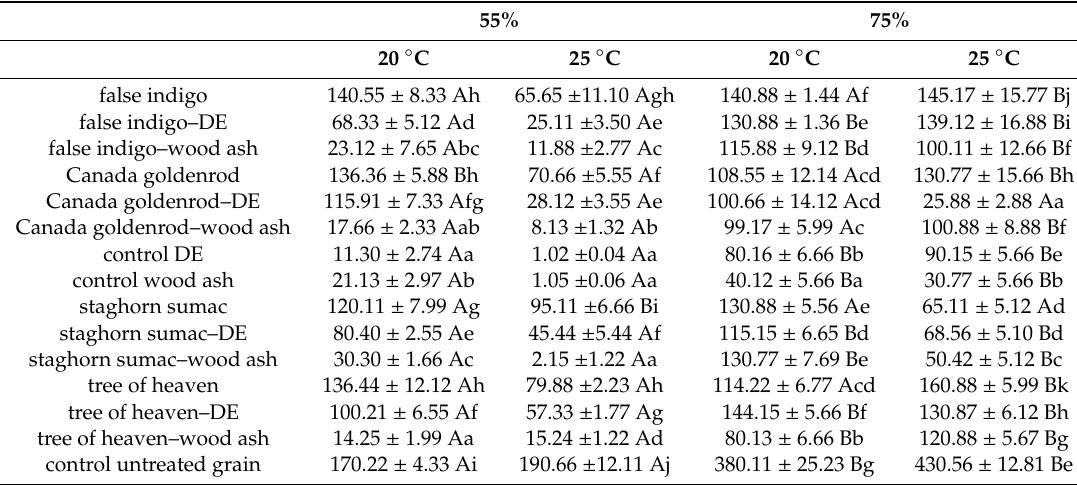
Table 9. Progeny production of Sitophilus